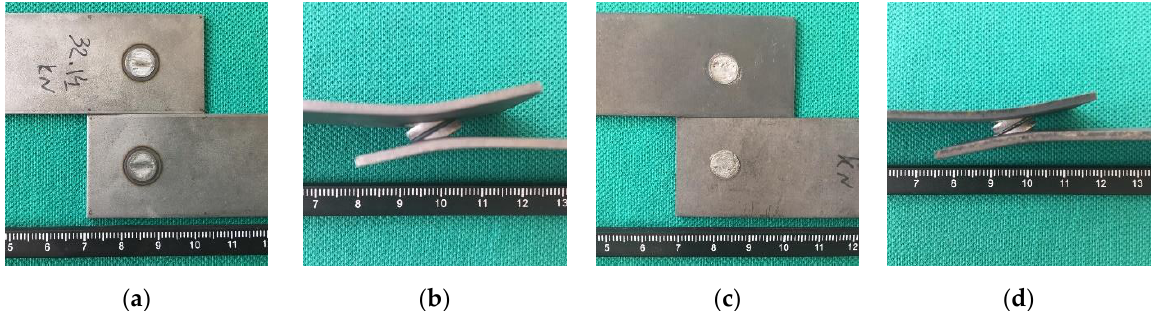
Figure 8. Typical failure modes of the specimens: ( a ) Interfacial failure (IF) in uncoated material (Sample No, N2); ( b ) Pullout failure (PO) in uncoated material (Sample No, N7); ( c ) IF failure in Al-Si coated material (Sample No, C3); and ( d ) PO failure in Al-Si coated material (Sample No, C6).